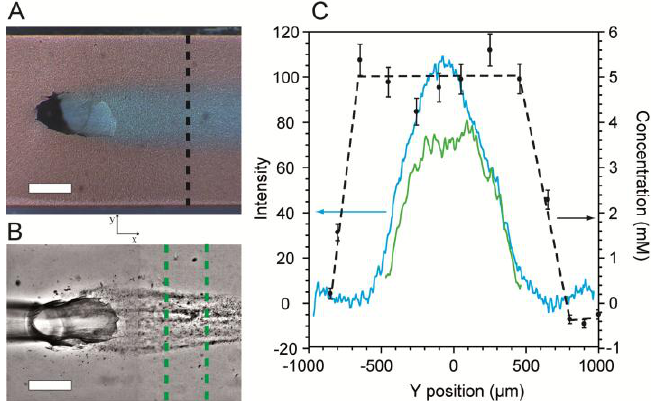
Figure 5. ( A ) An image of the microchannel in the vicinity of the junction with solutions of pure water (red) and 5 mM citrate (blue), respectively. ( B ) Micrograph the flow-templated Pseudomonas sp. bacterial biofilm after 48 h growth at 22 °C (with no dyes present in either solution phase) cultivated under the same flow conditions as in (A). ( C ) Cross-sections of the citrate solution and a flow-templated biofilm determined by optical density measurements and SERS. Concentrations profile of the citrate solution (black data points) was measured by SERS along the path marked in (A).The citrate concentration was determined by the conversion of the intensity ratio of νC-COO (952 cm −1 ) and νO-H (3,435 cm −1 ) using a calibration curve (Figure 4B). Error bars were derived from the uncertainty on the linear regression that defined the calibration curve. The black broken line is for eye guidance. The cross-section of the citrate analyte stream from (A) was acquired by image analysis of the blue colour optical density at various paths positions along the length of the channel and averaging their results (solid blue line). The optical density cross-section of a flow-templated biofilm (solid green line) was acquired by averaging data from individual micrographs acquired between 48 and 56 h after inoculationin the region shown in (B). Scale bars in A and B are 500 μ m. The flow rates used in A-C were Q = 0.15 mL/h and 2 Q = 0.34 1